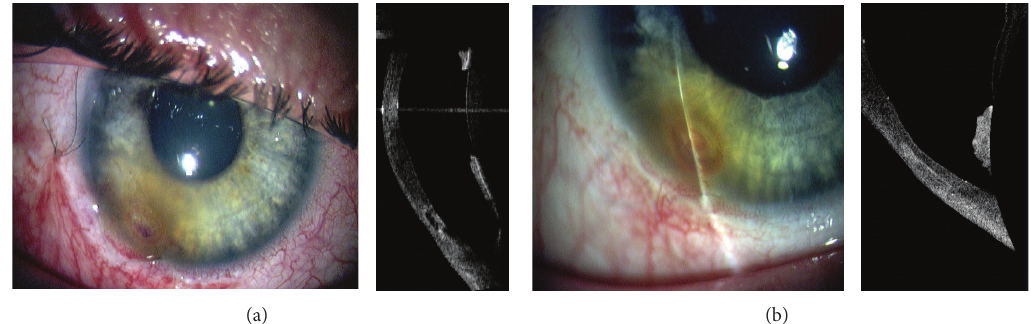
Figure 4: (a) Slit lamp photograph and corresponding AS-OCT of metallic foreign body. (b) Slit lamp photograph and corresponding AS- OCT of resulting rust ring and thinning after foreign body removal.